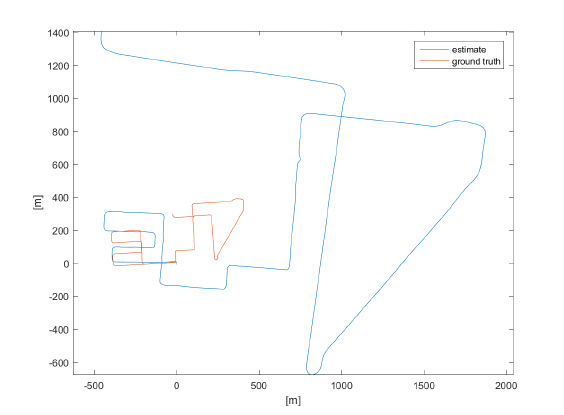
Figure 4. Tracking result for the sequence 08 of the KITTI odom- etry challange, with absolute scale estimation enabled only at the beginning of the sequence. The scale drifts towards larger